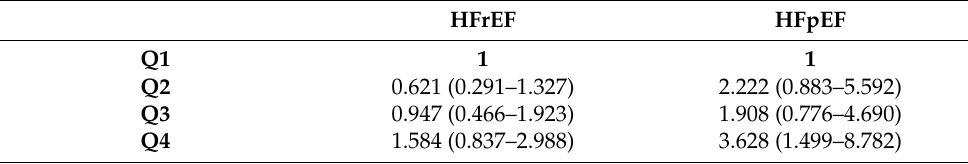
Figure 2. Kaplan–Meier survival curves from HF patients divided according their sAXL levels (upper panels) and NT-proBNP levels (lower panels). The graphs represent the survival from all-cause mortality. Left panels, Kaplan–Meier event-free survival curve from HF patients with reduced ejection fraction (HFrEF) and right panels, Kaplan–Meier event-free survival curve from HF patients with preserved ejection fraction (HFpEF). Survival of patients with sAXL or NT-proBNP values below the 4th quartile cut-off point is shown in black line, while survival of patients with sAXL or NT-proBNP above the 3rd quartile is shown in red line. The differences in survival were compared with the Cox Regression model. Table 5. Cox regression for absolute sAXL levels in quartiles and all